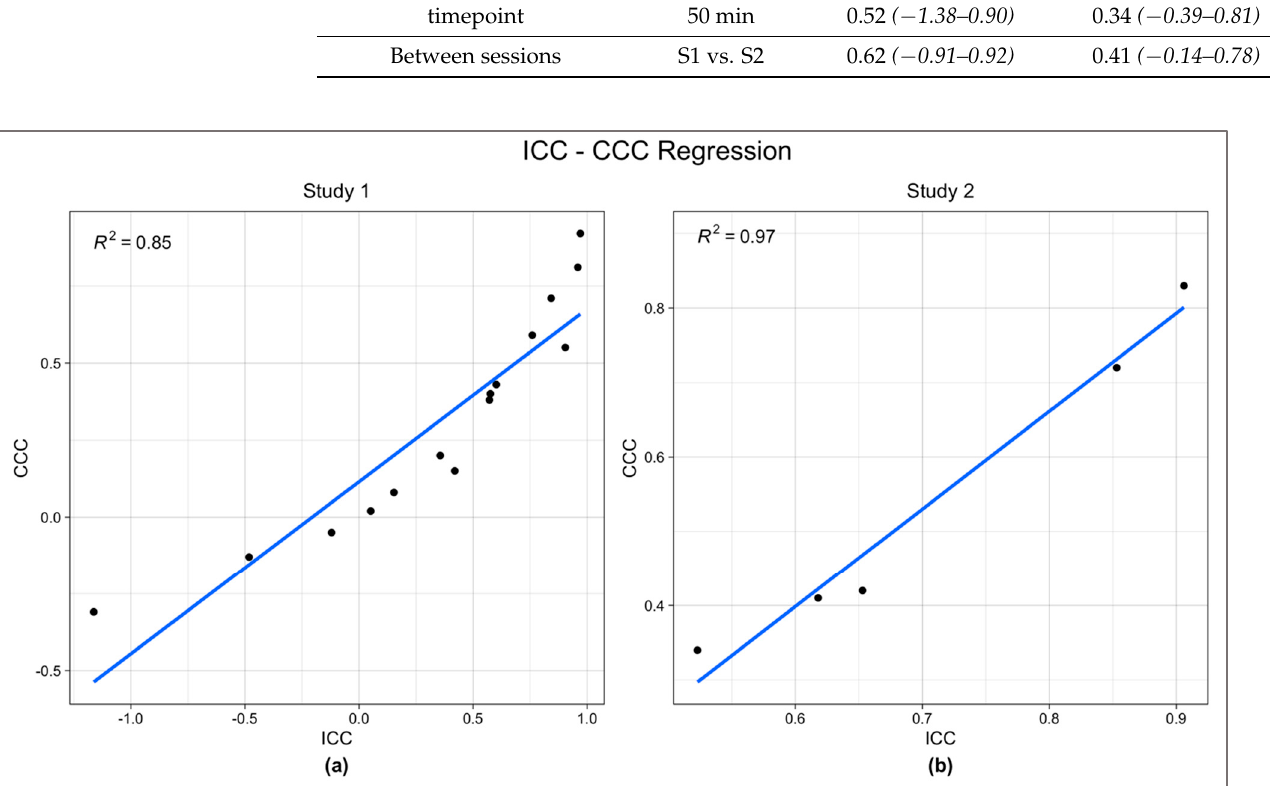
Table 5. Remaining ICCs from Study 1. In parenthesis the 95% confidence